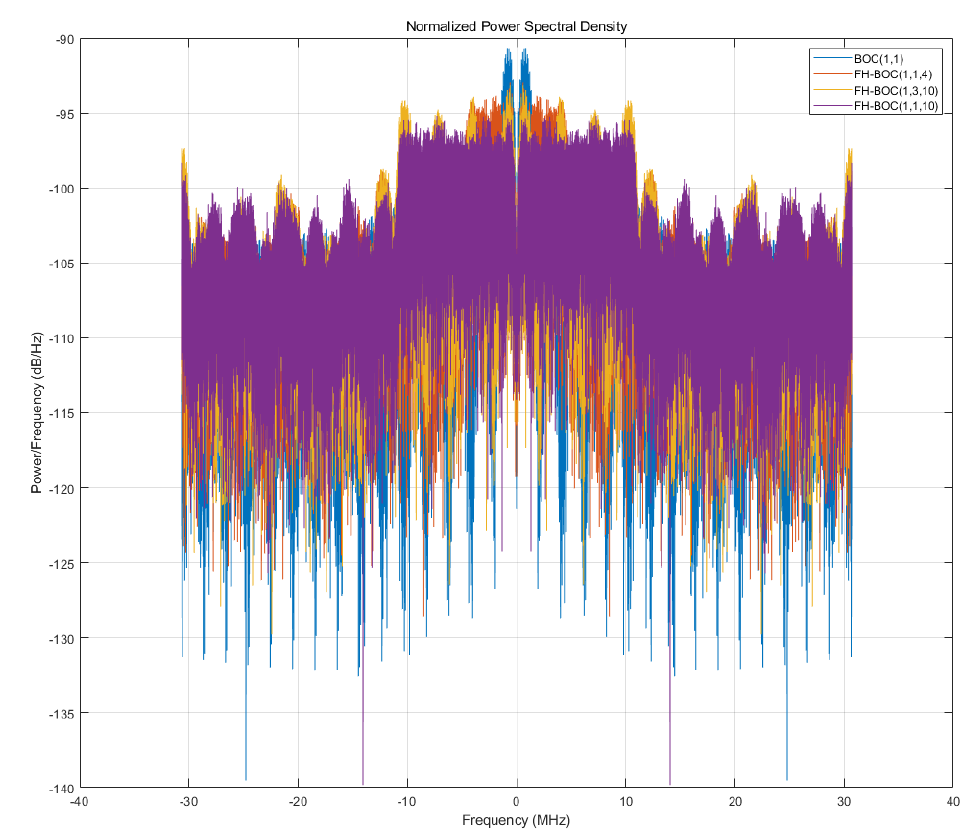
Figure 6. Power spectral density comparison between FH-BOC signals.